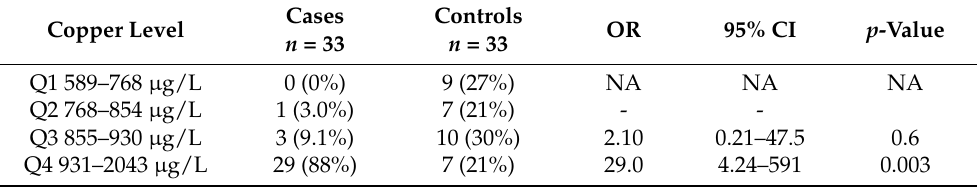
Table 9. Blood copper levels and the occurrence of colorectal cancer among G3